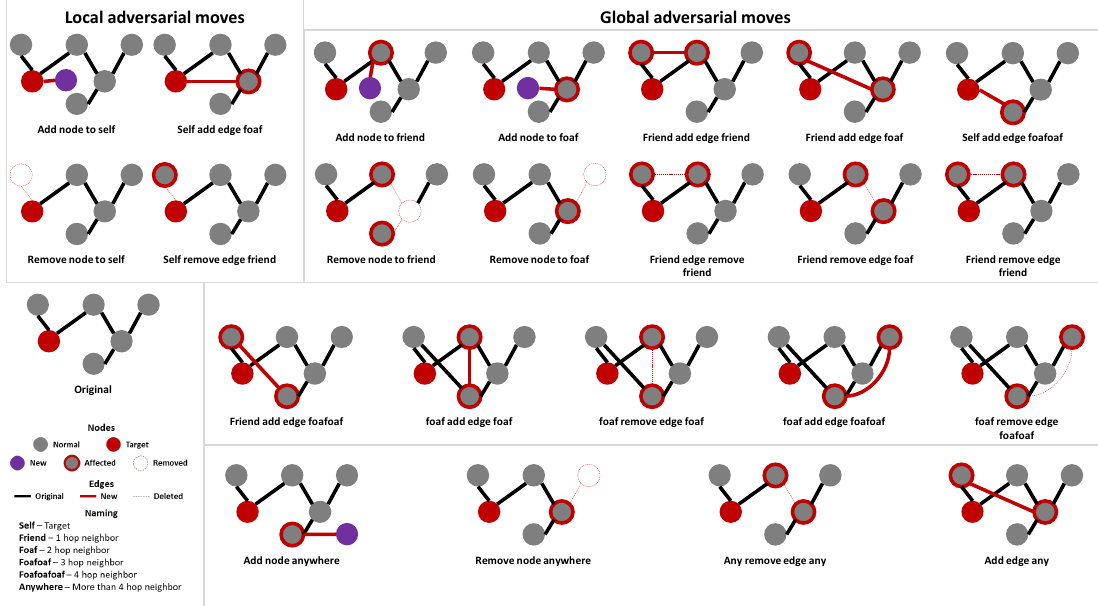
Figure 2. Possible set of moves imposed on the target node (red) in a